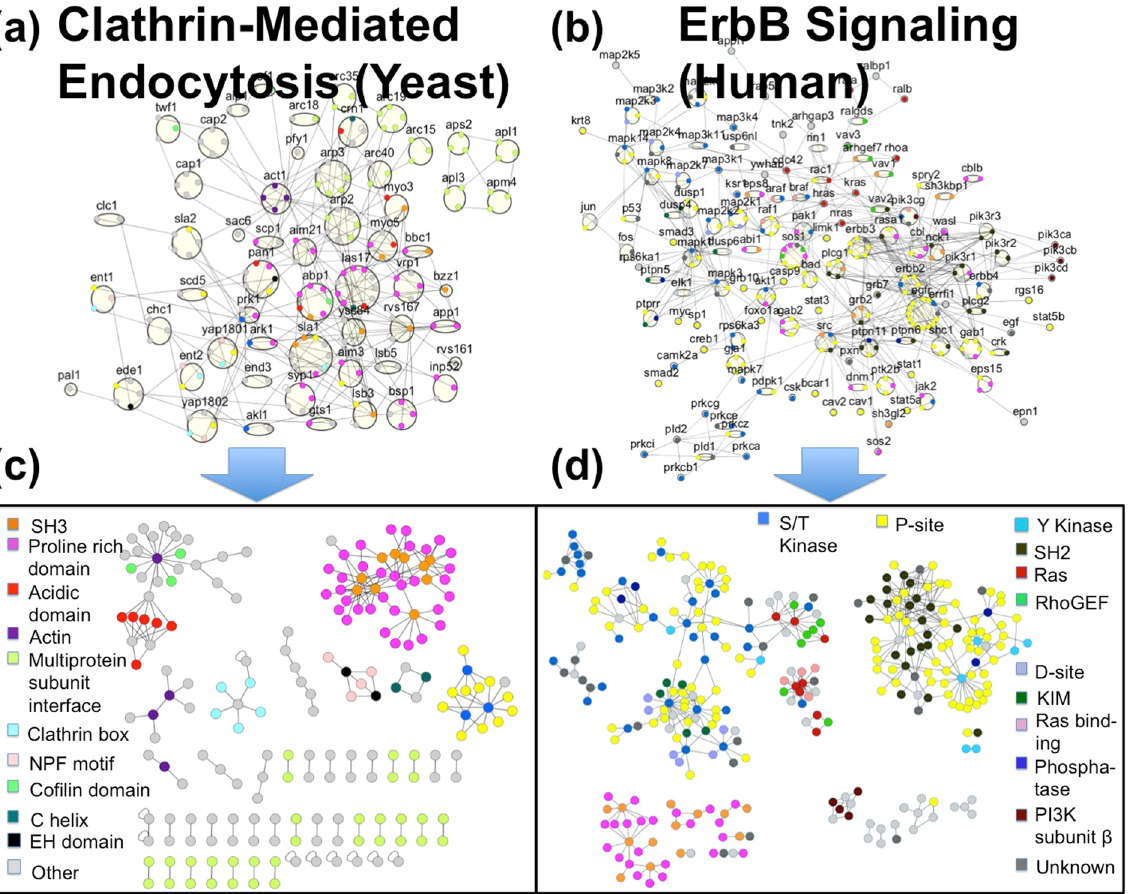
Figure 1. PPINs all contain hub proteins and their IINs have distinctive topologies. We analyze the PPINs of the manually curated yeast endocytosis (a) and human ErbB networks (b) with all domains and interfaces identified and shown here colored by domain type (Table S2). The resulting interface interaction networks (IINs) in (c) and (d) , respectively, have highly distinct topologies that reflect the needs of interfaces to achieve strong functional binding and minimize non-functional interactions. Both IINs break into multiple components with a selection of hub interfaces, and they contain an abundance of hub and square motifs with a minimal (or zero) number of triangle